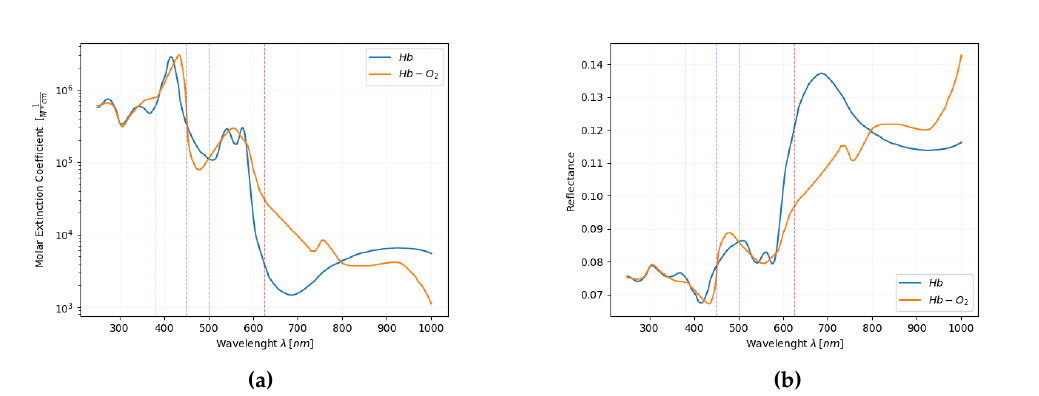
Figure 1. Plots visualizing optical absorption and reflectance of Hb and HbO 2 , vertical dashed lines are related to human perception of colors associated with ( λ ). ( a ) Molar extinction coefficient ( (cid:101) ) related to absorbance over wavelength ( λ ) considering 15 g/dL of hemoglobin concentration and 1 cm cuvette. ( b ) Derived reflectance plot of absorbance under same